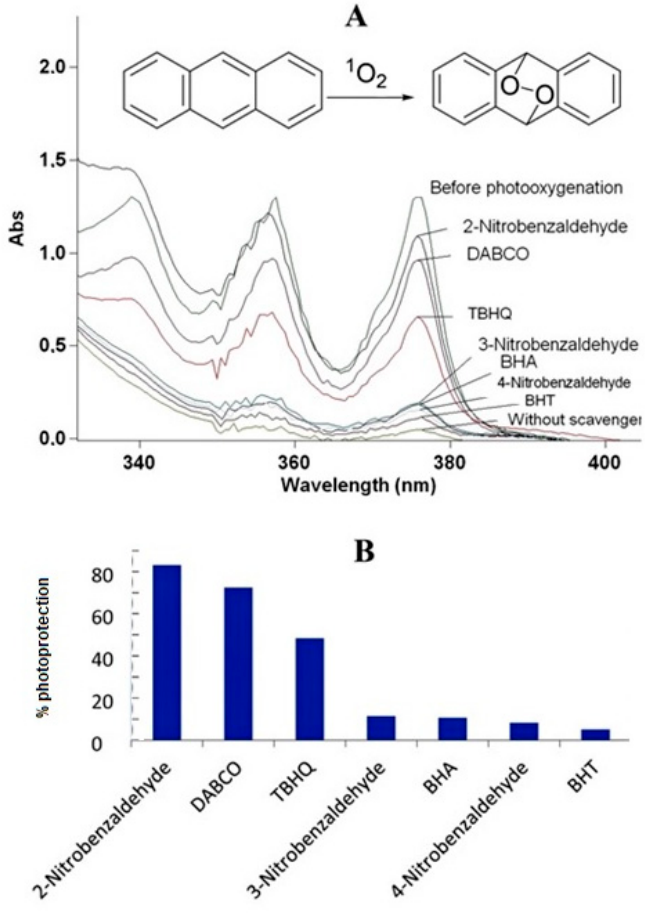
Figure 1. Variations of UV-Vis absorption spectra due to anthracene photooxidation after 45 min of exposure to methylene blue (MB) as a photosensitizer irradiated with a combination of 419 nm and 575 nm fluorescence lamp light in the absence and in the presence of different kinds of singlet oxygen scavengers ( A ). Comparison of the photoprotective capacity of different kinds of singlet oxygen scavengers after 45 min of irradiation of the anthracene containing samples under the conditions described above ( B ). DABCO: 1, 4-diazabicyclo [2.2.2] octane; TBHQ: tert-butylhydroquinone; BHA: